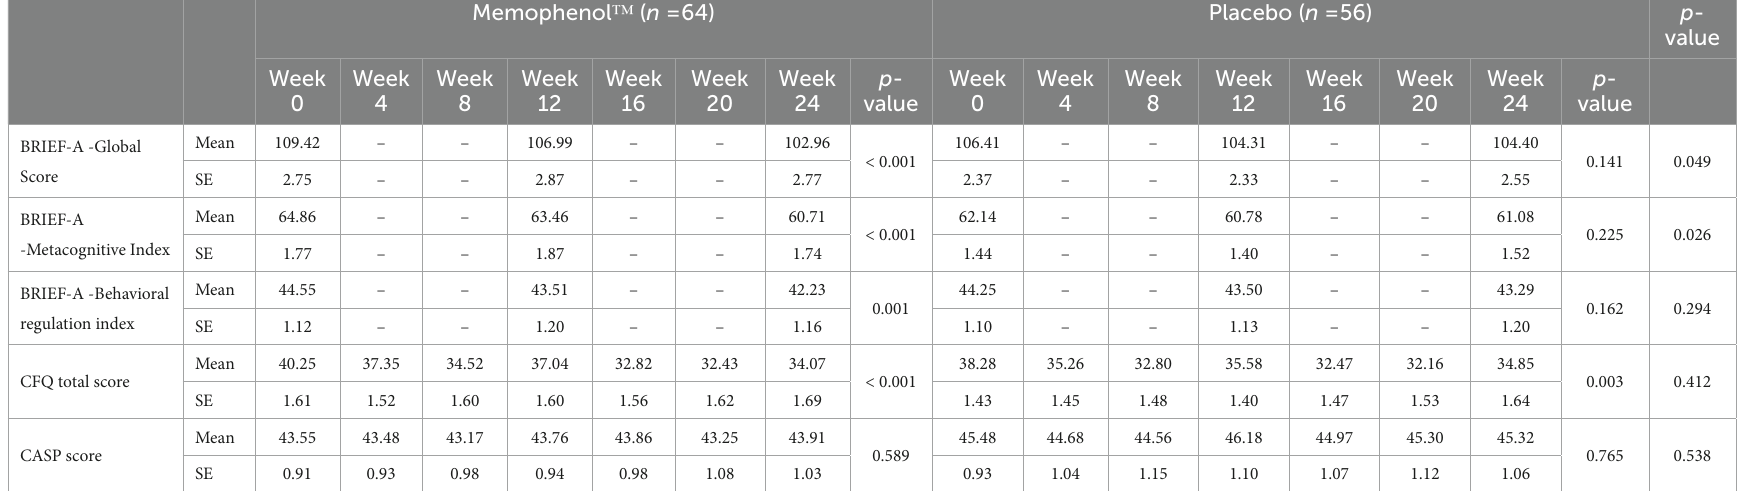
TABLE 4 Change in self-report questionnaires (estimated marginal